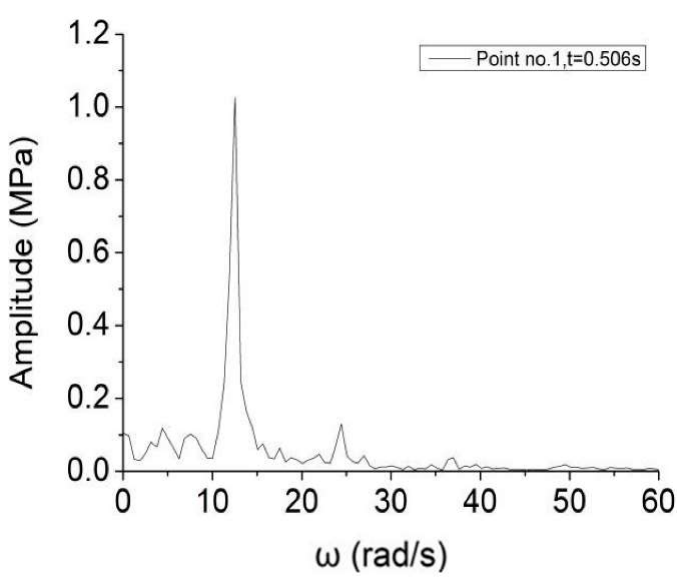
Figure 11. Stress amplitude spectrum of case 2.